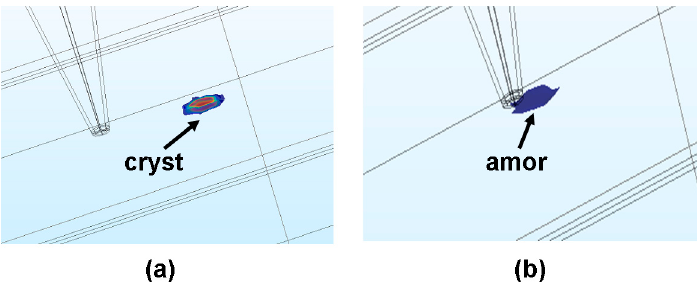
Figure 21. The 3D view of the resulting bits in ( a ) crystalline and ( b ) amorphous states. Reproduced with permission from [36]. Copyright Springer, 2018.